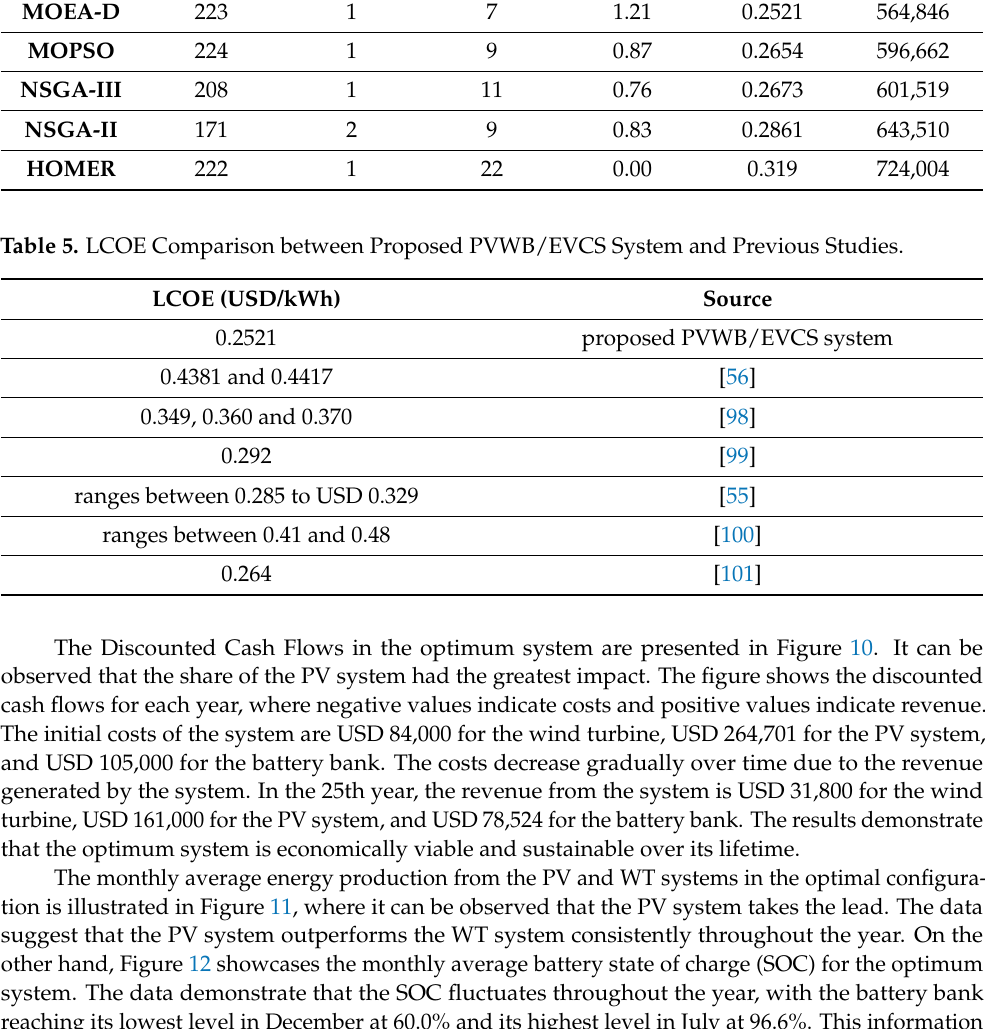
LCOE TNPC Battery LPSP (%) (USD) (units)